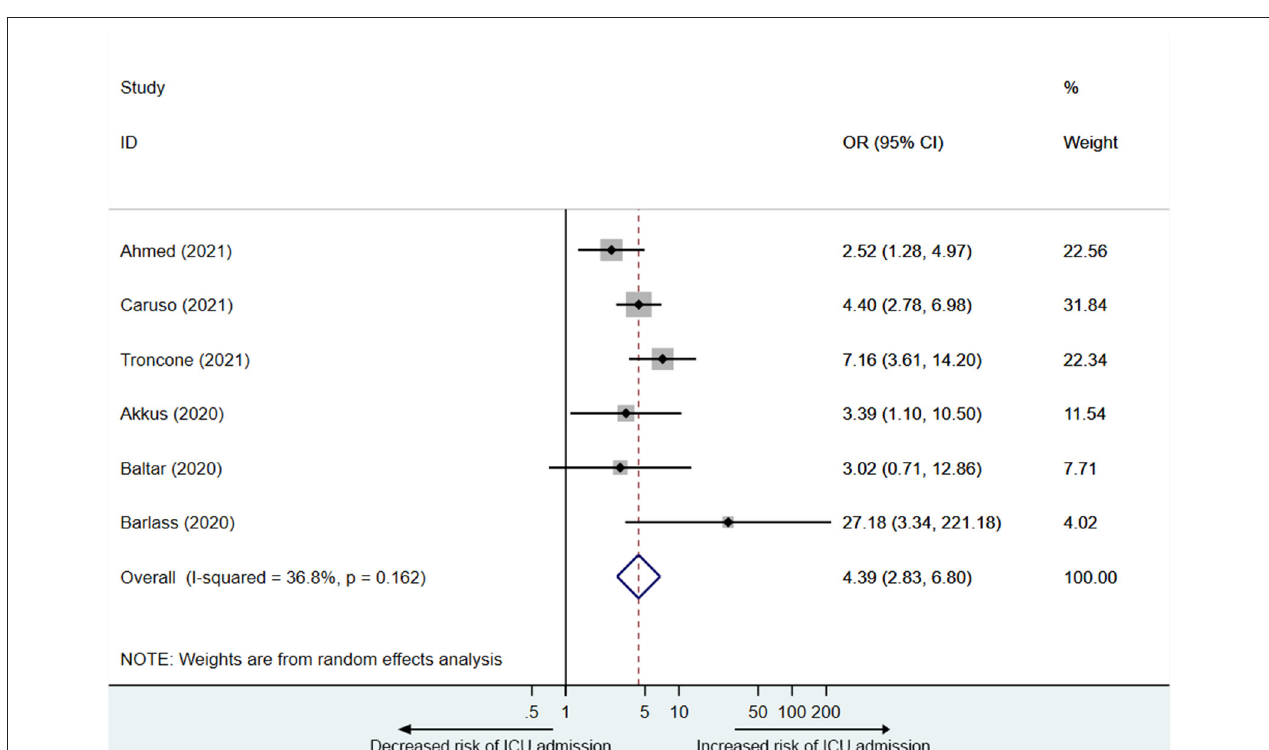
FIGURE 4 | Effect size analysis for ICU admission in COVID-19 patients with PE